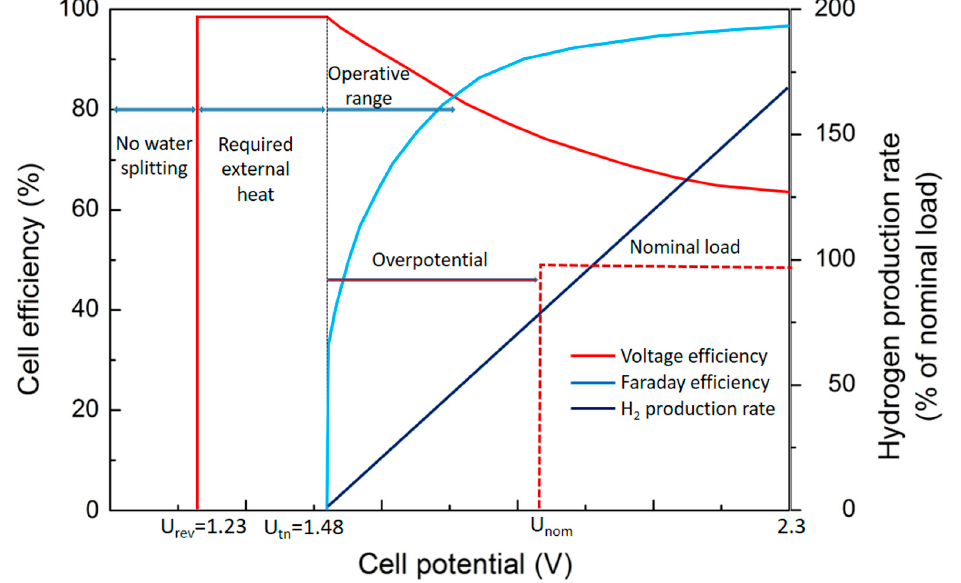
Figure 8. Ideal cell behavior as a function of the potential.